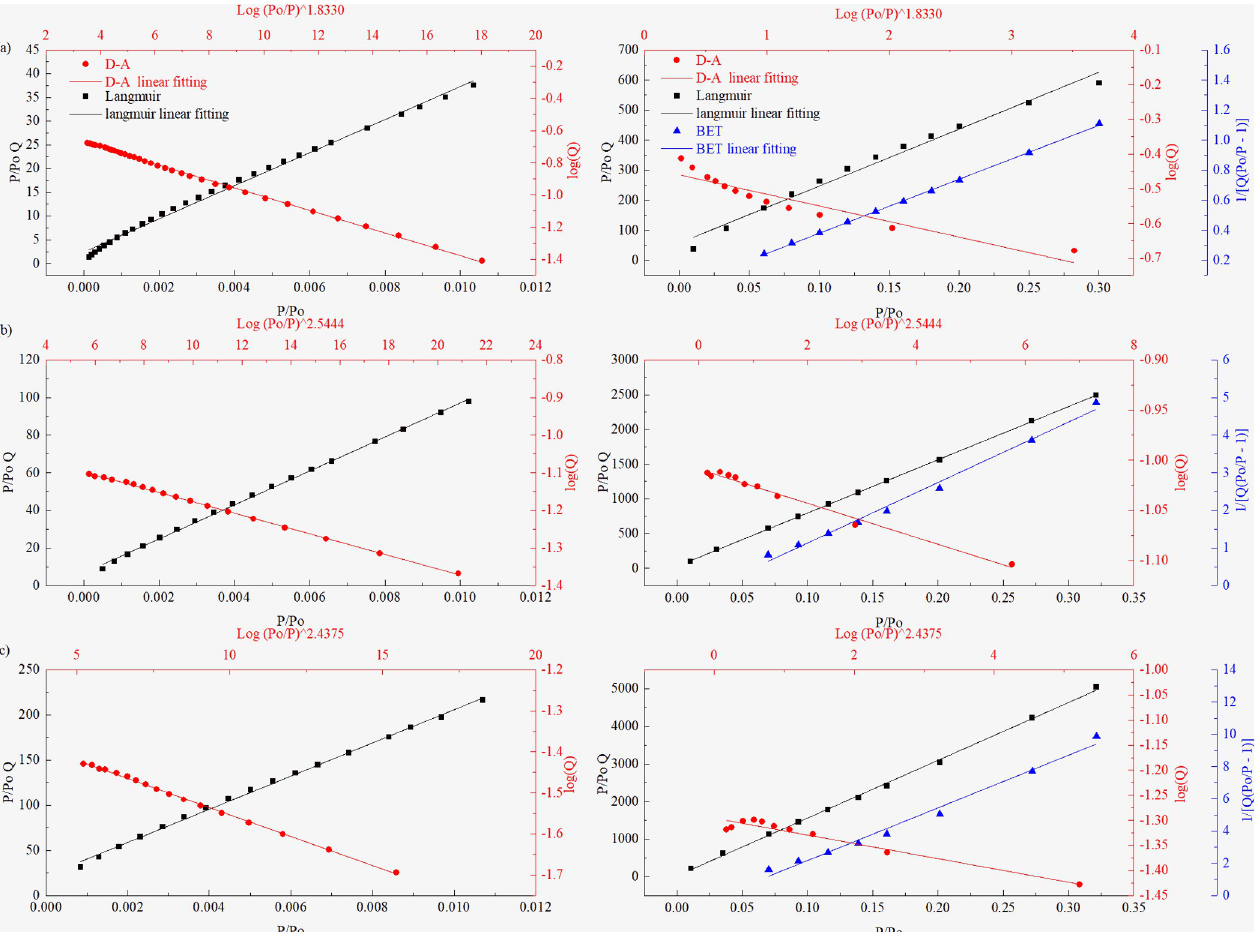
Fig 9. Fitting diagrams of coal samples of different coal ranks obtained using different models at different pressure sections. (a) HG Sample, (b) CV Sample, (c) YW Sample. (Left: Langmuir and DA model, Right: Langmuir, DA, and BET models).